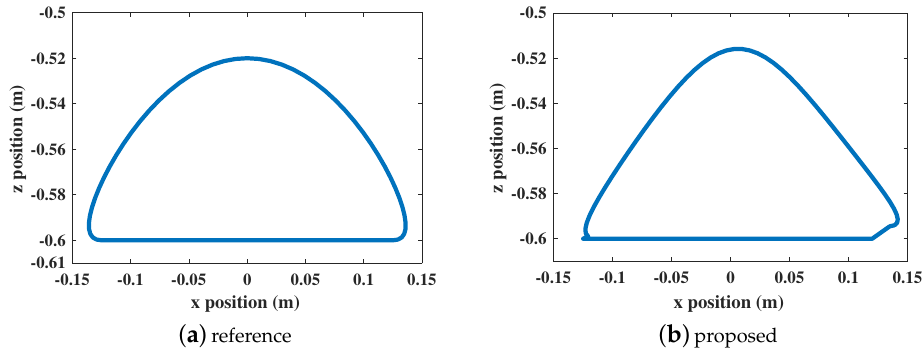
Figure 12. Foot trajectories of the RF leg in MATLAB.